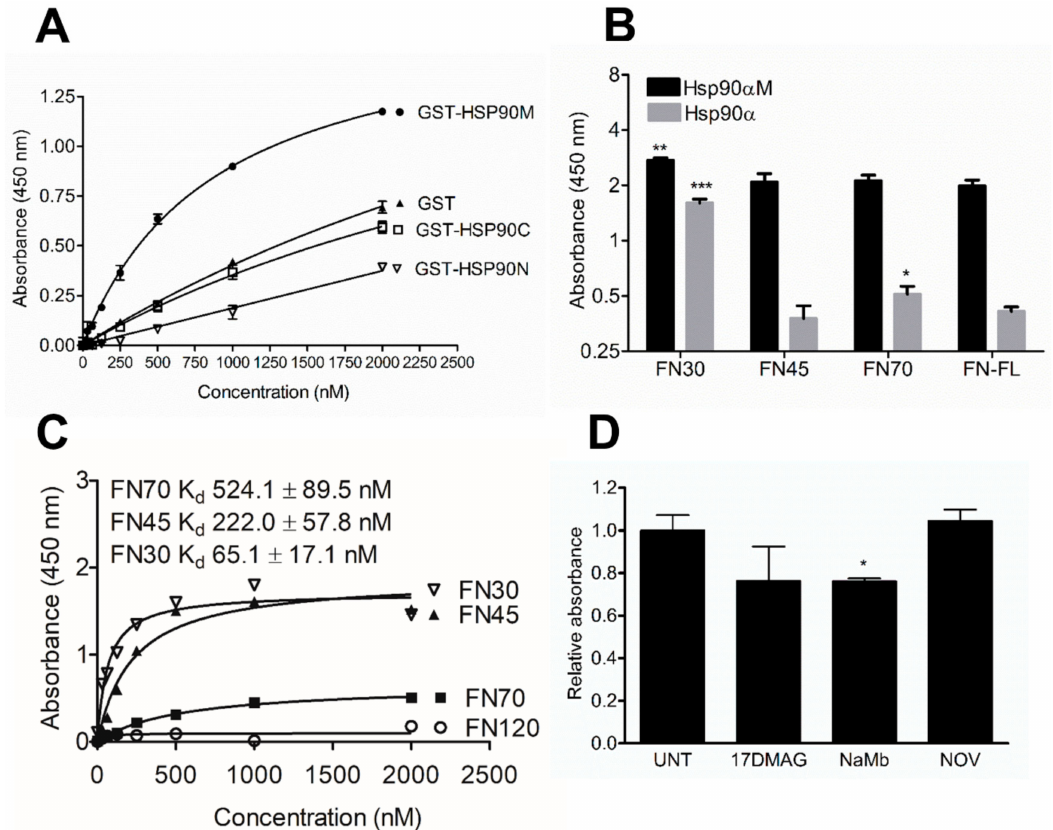
Figure 2. HSP90M and FN N-terminal domains are involved in direct interactions of the proteins. ( A ) Interaction of full-length FN (100 µ g / mL; coated on plate) with HSP90 α domains or GST control (varying concentration in solution). Binding was detected using an anti-GST antibody. ( B ) Interaction of HSP90 full-length and M domain with FN fragments. ( C ) Interaction of HSP90M domain (100 µ g / mL; coated on plate) with FN 30, 45, 70, and 120 kDa fragments (varying concentrations in solution). ( D ) E ff ect of inhibitors on the interaction between FN 30-kDa fragment and full-length HSP90 α . Data represent averages ( ± SD, n = 3). Statistical analysis was conducted by two-way ANOVA and Bonferroni post-test, where * p < 0.05, ** p < 0.01, *** p < 0.001 and ns = not